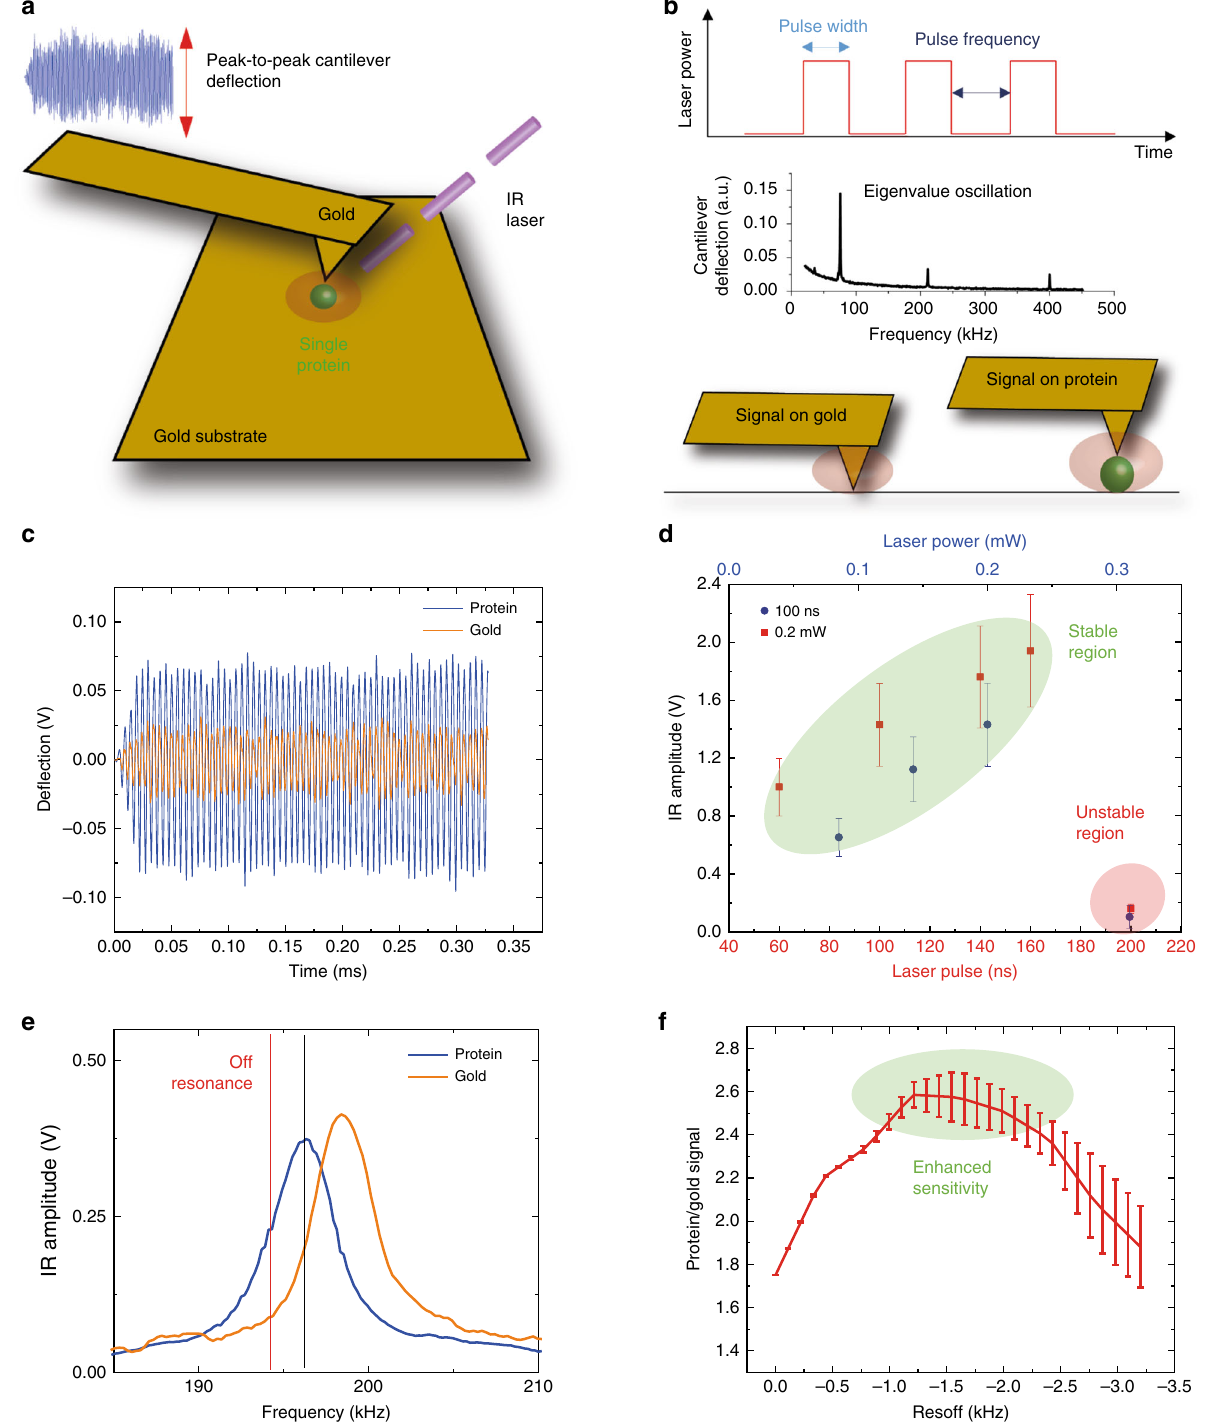
Fig. 1 Off resonance, short pulse, low power infrared (ORS-nanoIR) absorption spectroscopy of single protein molecules. a Scheme of the experimental setup, exploiting the rod-like antenna effect at the nanogap between a gold substrate and a gold cantilever. b Scheme of the pulsed excitation of the laser (top), of the eigenvalues of oscillation of the cantilever (centre) and of the laser hot spot on gold and on a protein (bottom). c Measurement of the cantilever de fl ection on gold and on a thyroglobulin molecule at a frequency of 194 kHz, power of 0.22 mW and at 1655 cm − 1 . d IR amplitude of the cantilever response on the bare gold substrate as a function of laser power and pulse at 1730 cm − 1 ; low values de fi ne the region of stability of the thermomechanical response (green circle) and high values can cause instabilities and drop of the signal (red circle). e IR amplitude as a function of frequency pulse for signal on gold and on a thyroglobulin molecule at a laser power of 0.22 mW and at 1655 cm − 1 . f Plot of the ratio between the IR amplitude of the signal on the protein and on the gold as a function of frequency. Since the tip interacts both with gold and protein, the maximum sensitivity in detecting the signal of the protein vs. the signal of gold (green circle) occurs for a laser frequency off resonance (red line) of the maximum of the response on the protein molecule (black line). In all panels, the error bars represent the average + s.d. Source data are provided as a Source Data fi